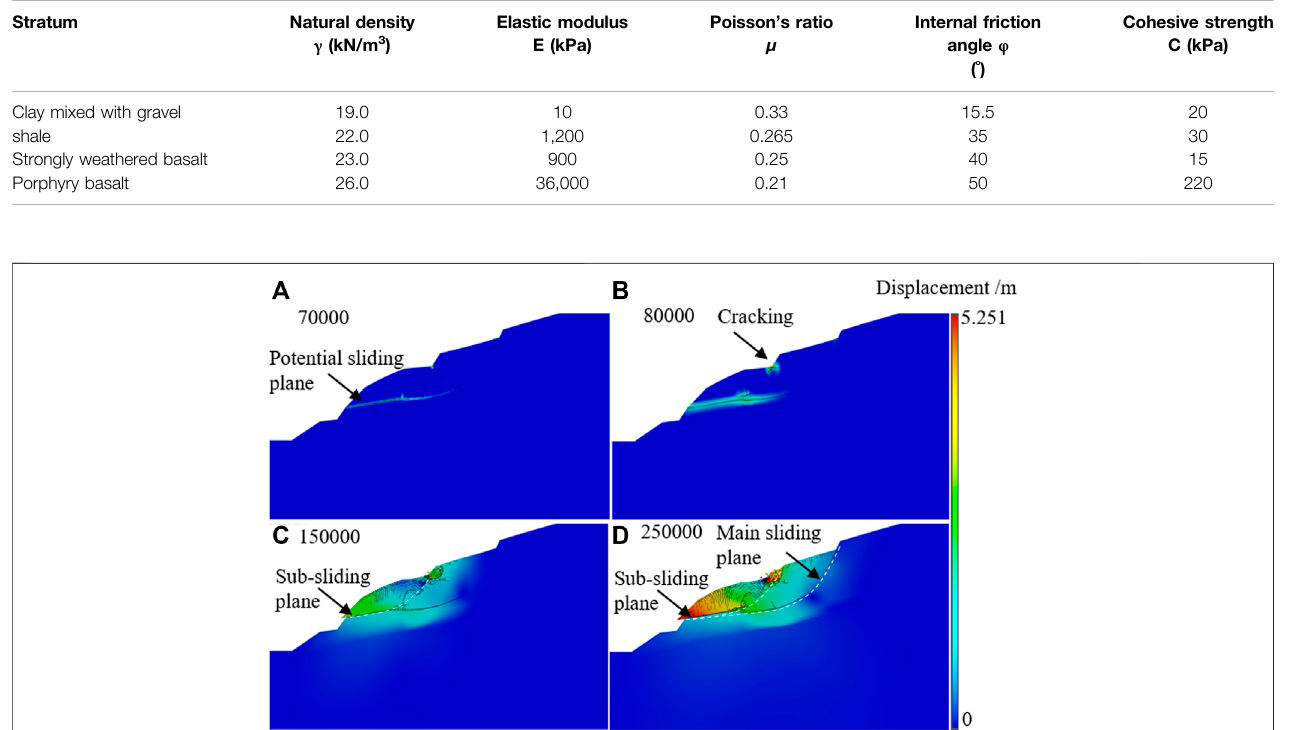
TABLE 1 | Numerical modeling parameters. Stratum